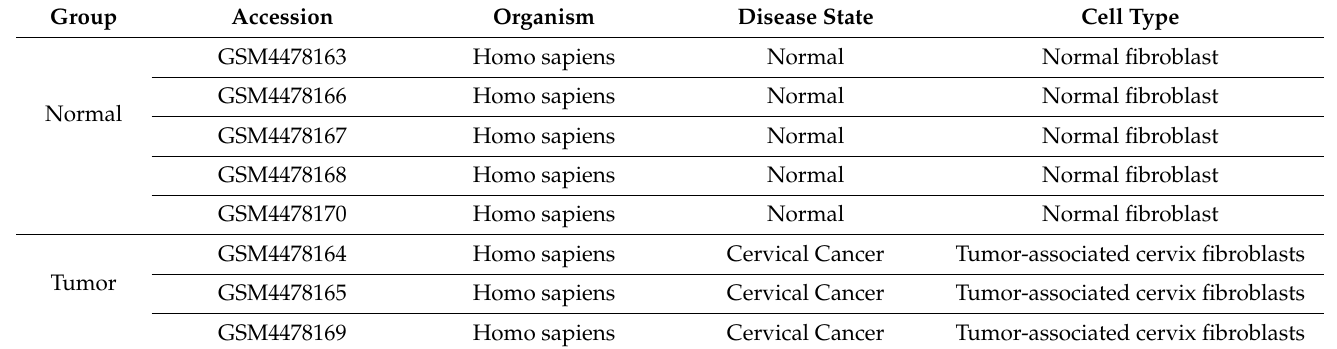
Table 1. Patients’ information in GSE148747 derived from the GEO database.